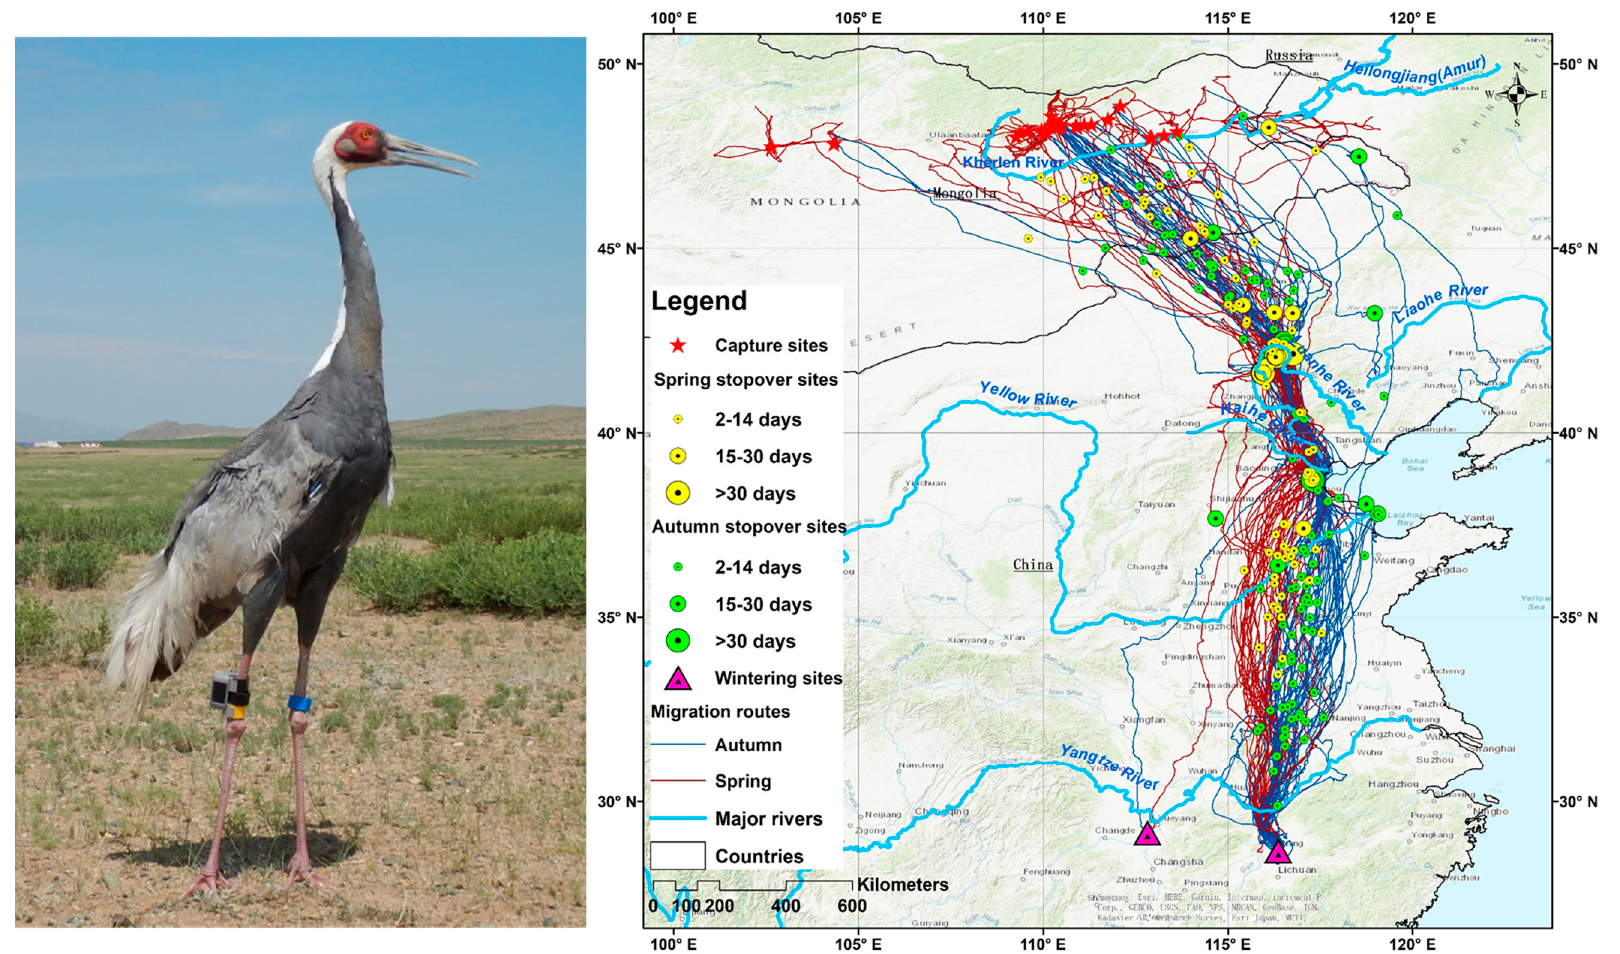
Figure 2. Spring (red) and autumn (blue) migration routes of white-naped cranes ( Antigone vipio ) and their stopover sites (spring yellow, autumn light green). Relative size of stopover site symbols reflect individual lengths of stay. The white-naped crane was photographed by Dr. Iderbat Damba on 6 July 2019 at Ugii Lake (47.755188°N, 102.652021°E) in Mongolia.